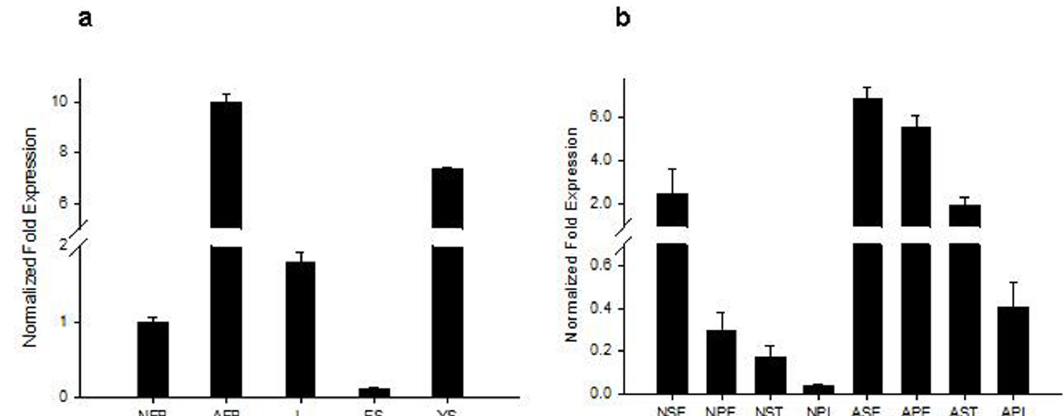
Figure 5. Expression analysis of RsVPE1 gene in radish plants. RsVPE1 expression in ( a ) radish plants and ( b ) the four parts of radish flower buds. NFB, normal flower buds; AFB, aborted flower buds; L, leaves; FS, flower stalks; YS, young siliques; NSE, sepals of normal flower buds; NPE, petals of normal flower buds; NST, stamens of normal flower buds; NPI, pistils of normal flower buds; ASE, sepals of aborted flower buds; APE, petals of aborted flower buds; AST, stamens of aborted flower buds; API, pistils of aborted flower buds. Error bars represent the mean ± SD of three independent biological